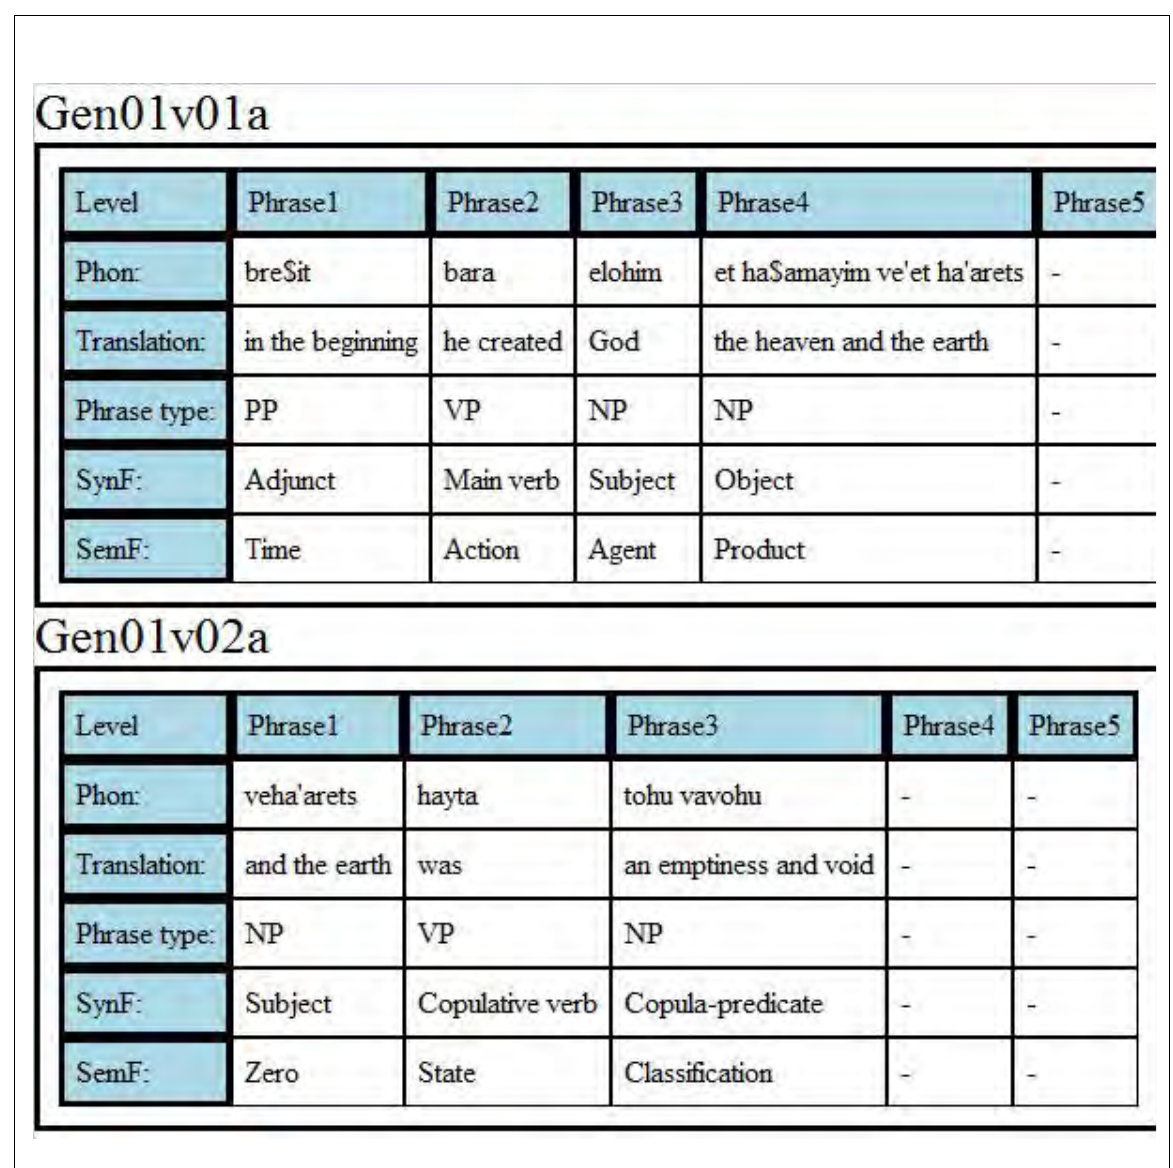
Figure 8. The first two clauses of the XML database as displayed in the Firefox web browser as two twodimensional